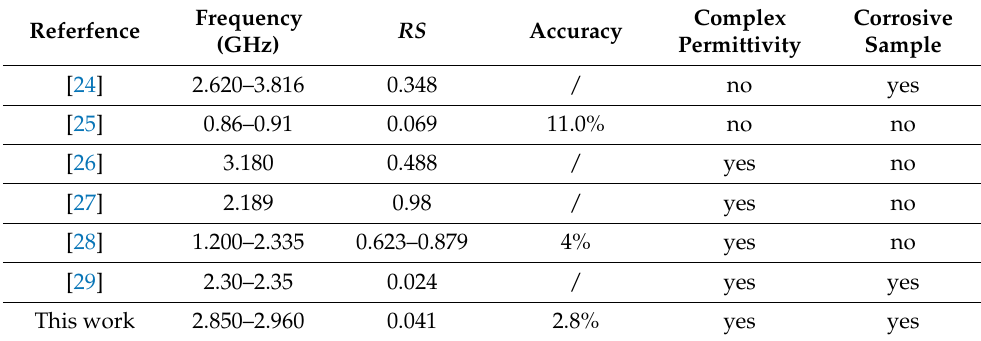
Table 4. Comparison of various liquid microwave microfluidic